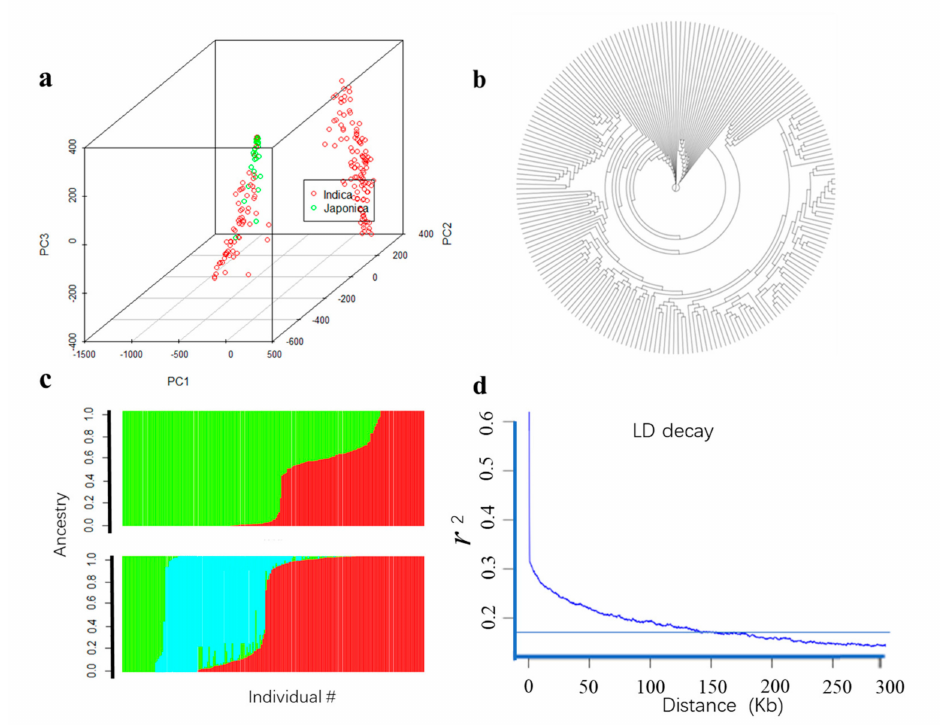
Figure 3. Population structure and LD decay of 208 rice accessions. ( a ) Principal component plot, di ff erent colors represent di ff erent ingredients; ( b ) neighbor-Jointing tree; ( c ) structure; ( d ) LD decay